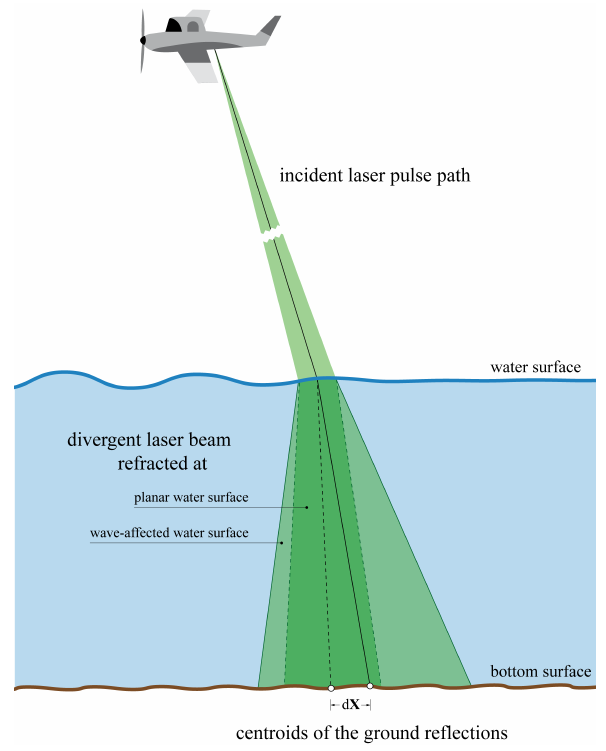
Figure 1: Effects of wave patterns on 3D point